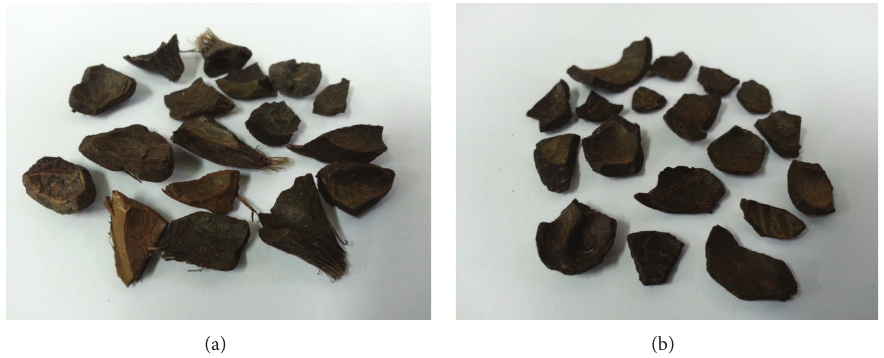
Figure 3: Crushed dura (a) and tenera (b) OPS coarse aggregates.